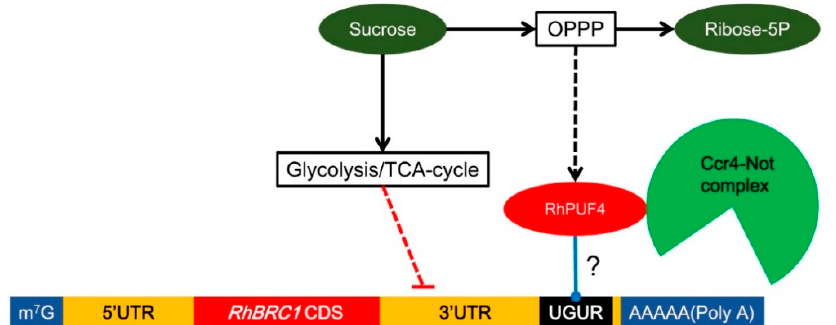
Figure 8. RhPUF4 could bind the 3 ′ UTR of RhBRC1 to regulate its expression. There exist putative PUF-binding sites in the 3 ′ UTR of RhBRC1 . APUM2 proteins can recruit the Ccr4-Not complex to the 3 ′ UTR of target mRNAs and enhance the degradation of target mRNAs by cutting the poly(A) tail [89–91]. Moreover, the transcription of RhPUF4 is stimulated by the OPPP, which is itself enhanced by sucrose. Blue line means protein interaction. Dashed line means indirect effect.